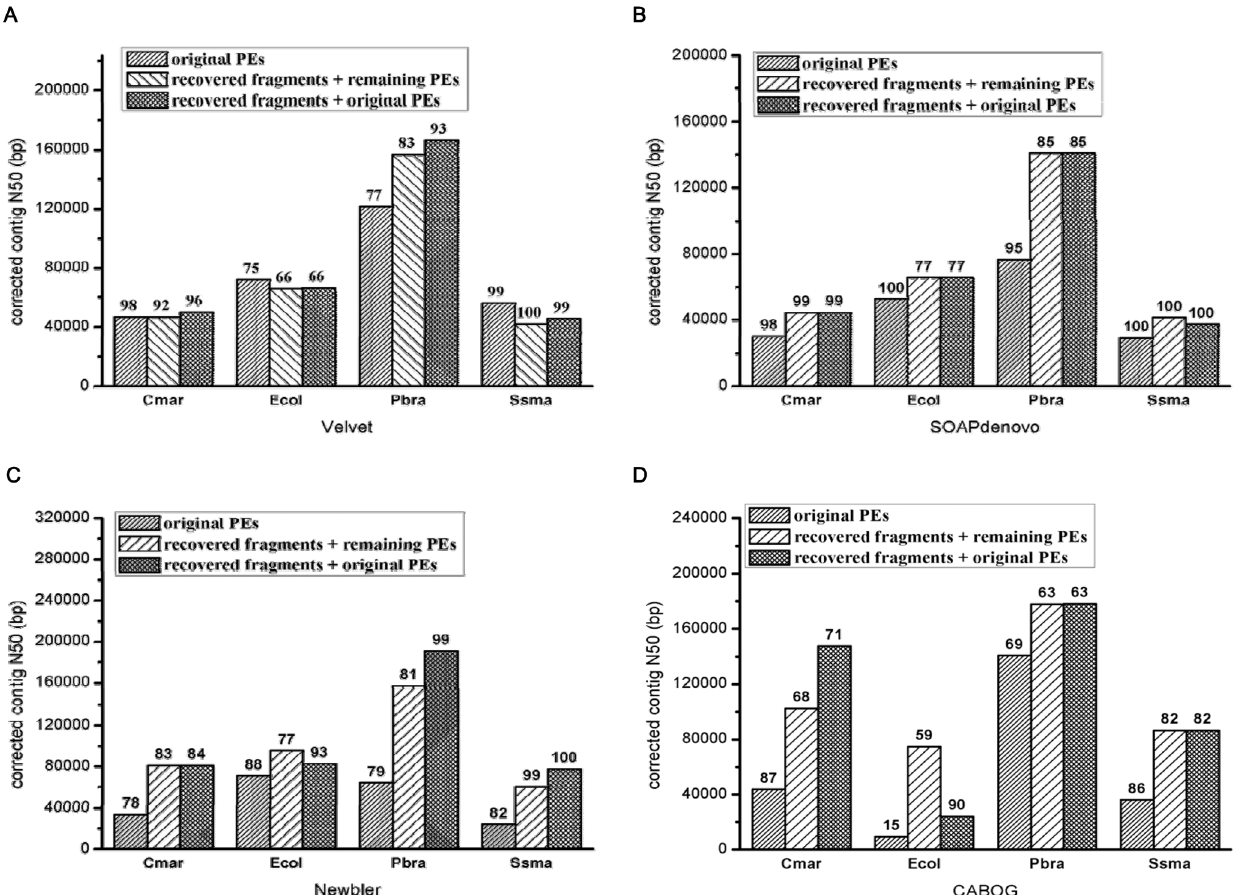
Figure 2. Metrics of four bacterial assemblies by four assemblers. We show the corrected N50 lengths (y-axis) and accuracies (numbers on top of bars) of the four bacterial assemblies by four assemblers: (a) Velvet, (b) SOAPdenovo, (c) Newbler, and (d) CABOG. The accuracy of an assembly is defined as the ratio of the corrected N50 length to the N50 length before correcting assembly errors, and ranges from 0 to 100%. The four species are C. marinum , E. coli , P. brasiliensis , and S. smaragdinae . For each species, each assembler treats three types of data: original PE reads, recovered DNA fragments and the remaining PEs, and recovered DNA fragments and original PEs.